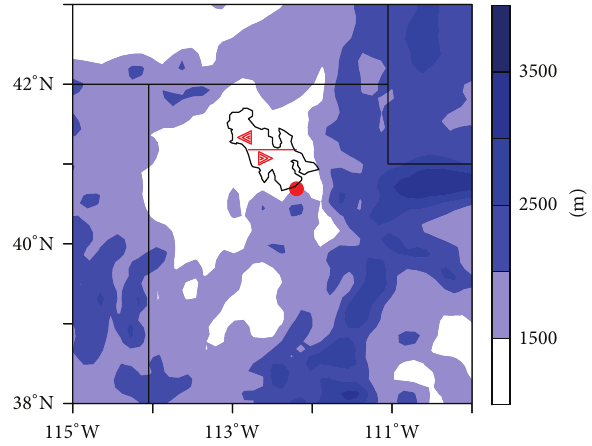
Figure 1: Terrain height (m) (blue shade) of the GSL area, GSL, and observation stations(redcircle filled: Garfield; black left triangle filled: Gunnison island; black right triangle filled: Hat